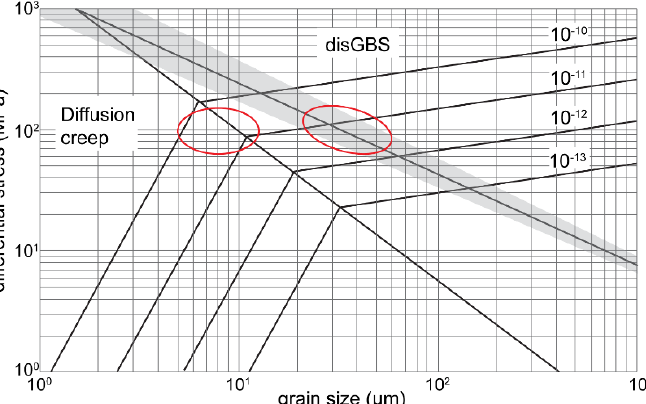
Figure 14. Olivine deformation mechanism map at 850 °C, showing in light gray the paleopiezometer [43]. The red circle on the right shows the average olivine grain sizes of the matrix (23–45 µm, Table 1) and the corresponding differential stresses calculated with the paleopiezometer. The left circle shows the range of average olivine grain sizes in the ultramylonite layers (5–12 µm, Table 1). Diffusion creep flow law from [14] and the disGBS flow law from [13]. Supplementary Materials: The following are available online at www.mdpi.com/xxx/s1, Figure S1: EBSD data of a recrystallized cpx porphyroclast, Figure S2: EBSD maps of the olivine matrix, Figure S3: EBSD data of a recrystallized opx porphyroclast, Figure S4–S6: EBSD data of fine-grained layers, Table S1: Microprobe data of pyroxenes. Author Contributions: Conceptualization, J.L. and S.T.; methodology, J.L. and S.T.; validation, J.L., S.T.; formal analysis, J.L., S.T.; investigation, J.L., S.T.; data curation, S.T.; writing—original draft